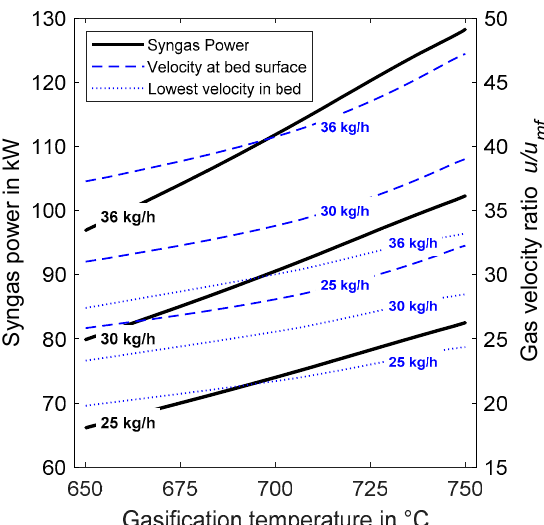
Figure 12. Power of syngas for gasification temperatures between 650 and 750 °C for water-free fuel input of 25 kg/h, 30 kg/h, and 36 kg/h (left side); Corresponding gas velocity ratio (related to u mf ) at the top of the fluidized bed and for the position where the lowest velocity in the fluidized bed occurs (right side).